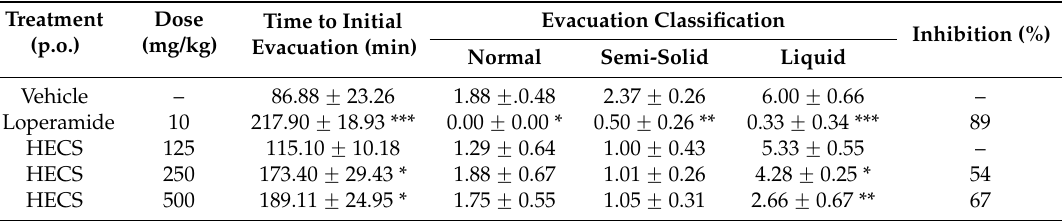
Table 2. Preventive antidiarrheal effects of the hydroalcoholic extract of Cissus sicyoides (HECS) on diarrhea induced by castor oil in mice.